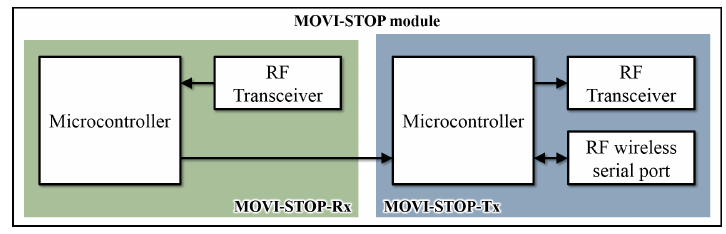
Figure 3. MOVI-STOP block diagram.